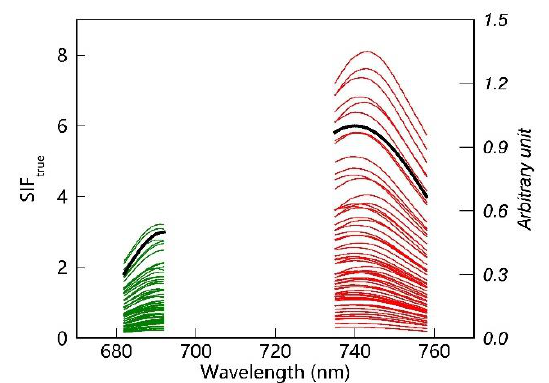
Figure 14. True SIF spectrum at red (green) and far-red (red) fitting windows derived using the SCOPE model and the fixed spectral function (black) based on the Gaussian function. σ h was set as 21 and 9.5 and λ 0 was set as 740 and 692 nm for the far-red and red band,